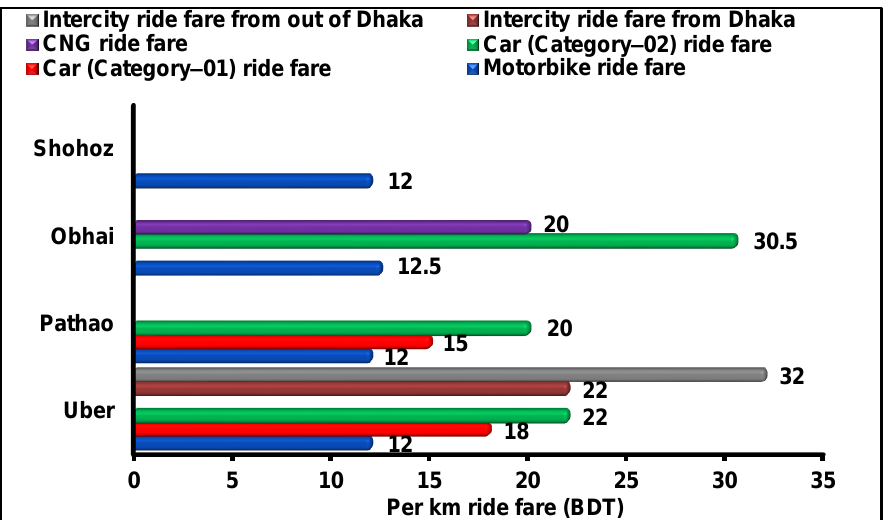
Fig. 7. Comparison based on per km ride